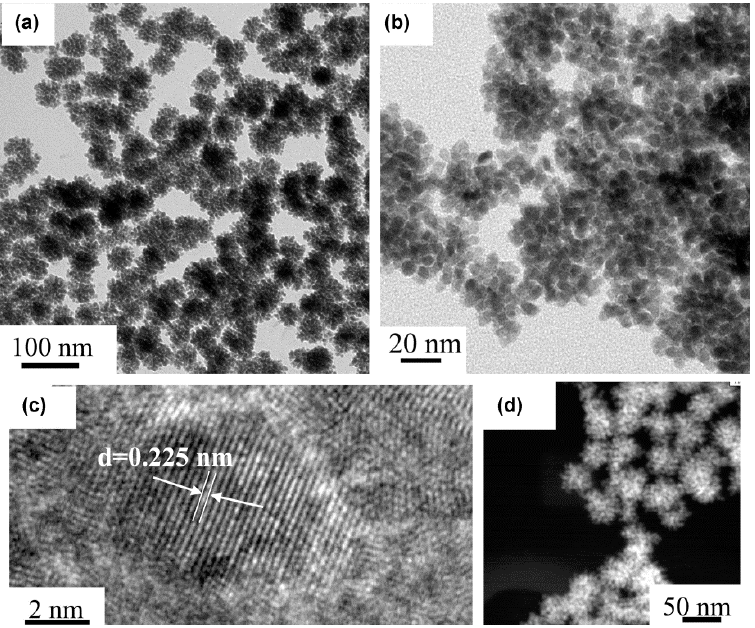
Figure 15. TEM images of Pd nanodendrites at different magnification ( a , b ); ( c ) HR-TEM image of Pd nanodendrites; ( d ) ADF-STEM image of Pd nanodendrites. Reproduced from Ref. [134] with permission from the ACS, 2009.